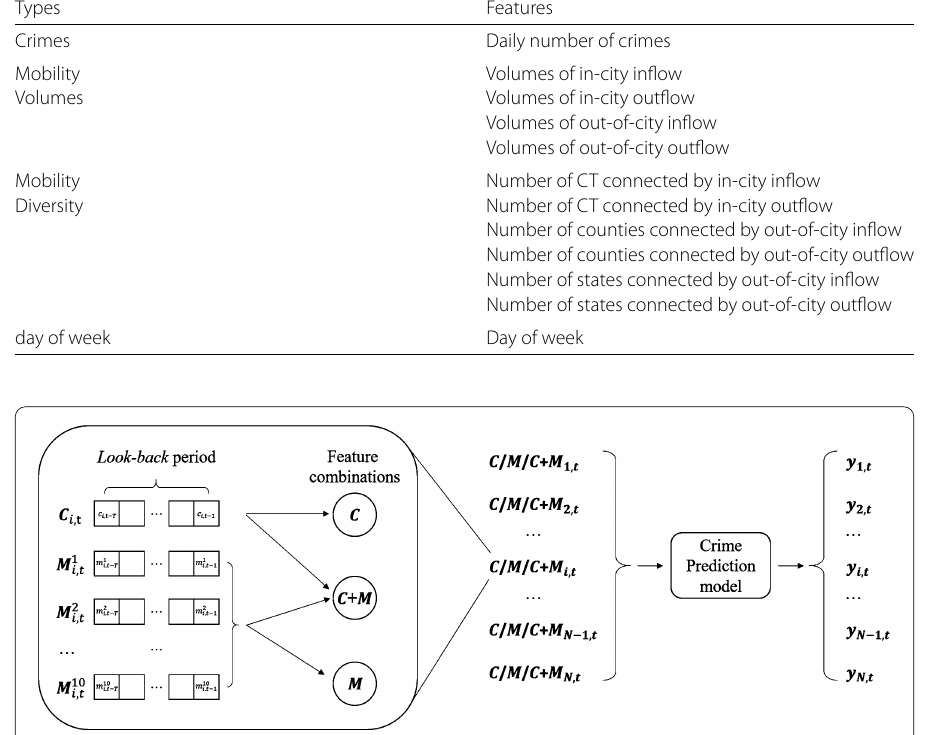
Figure 1 Framework of the place-based short-term crime